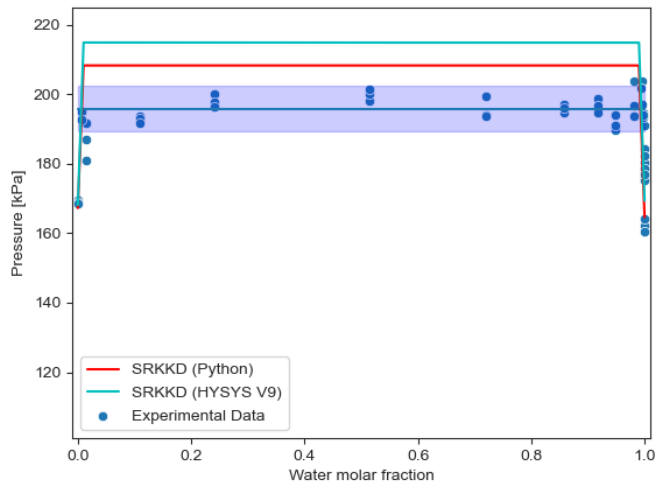
Figure 6. Comparison of VLLE experimental results for water/PASN using Python and HYSYS V9 at 80 °C.